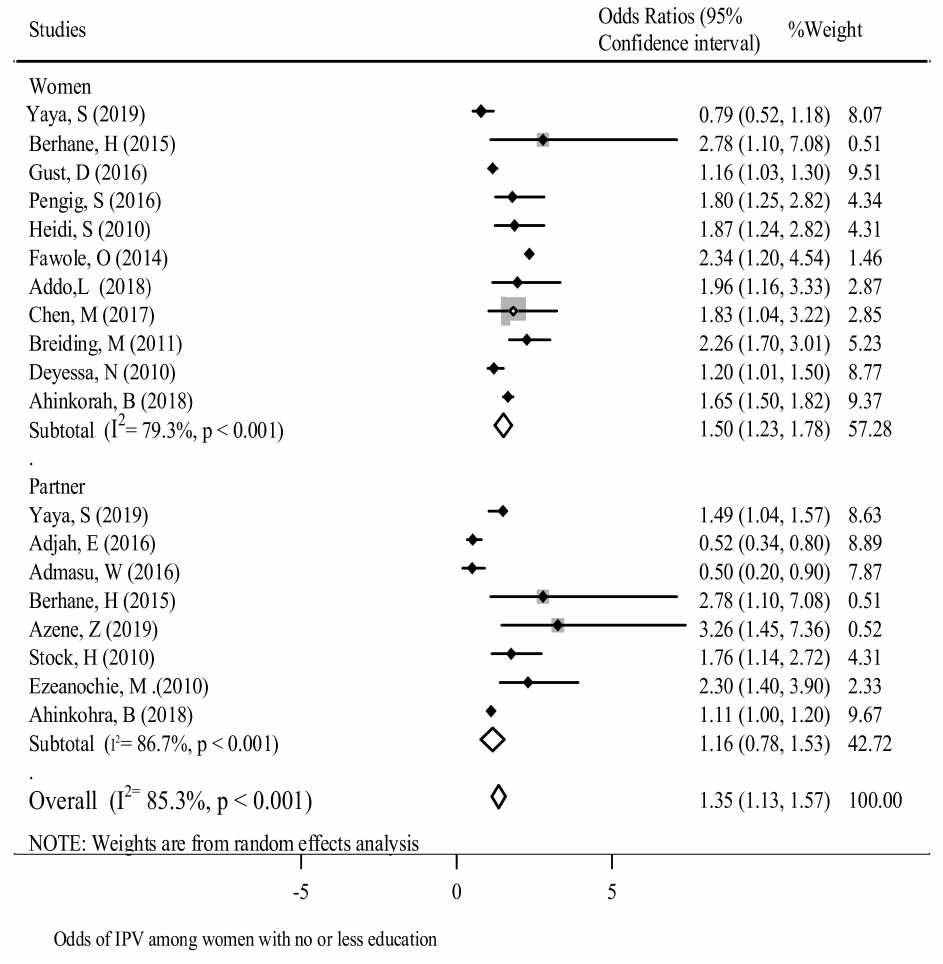
Figure 2. The association between education and experience of reporting GBV in